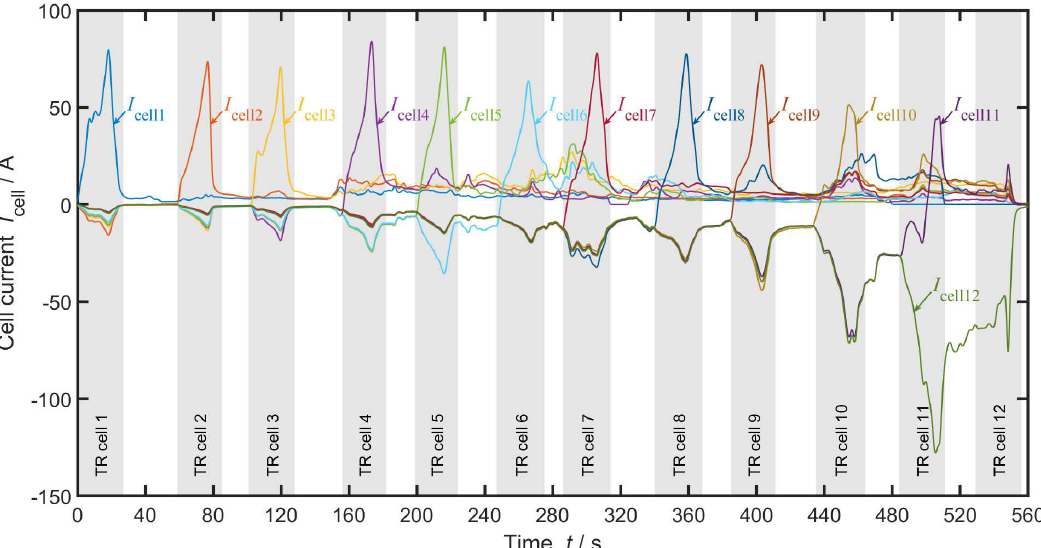
Figure 4. Current measurement during the 12p2s propagation test. Positive values indicate currents into the cell (charge direction), negative currents indicate currents out of the cell (discharge direction). The ribbons represent the time period of a visible TR